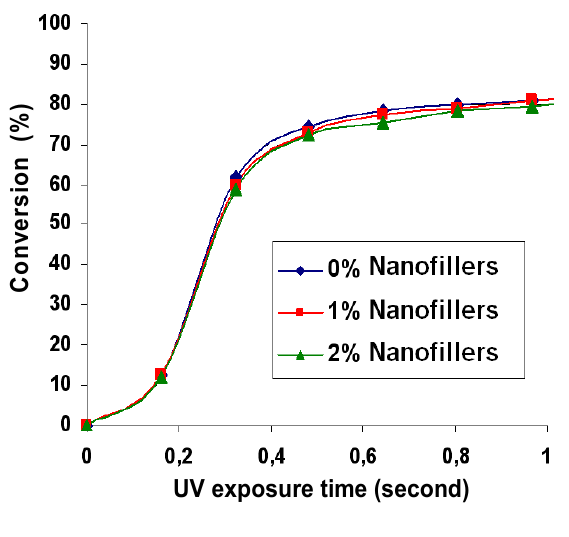
Figure 7. Conversion curves depending on the nanofiller